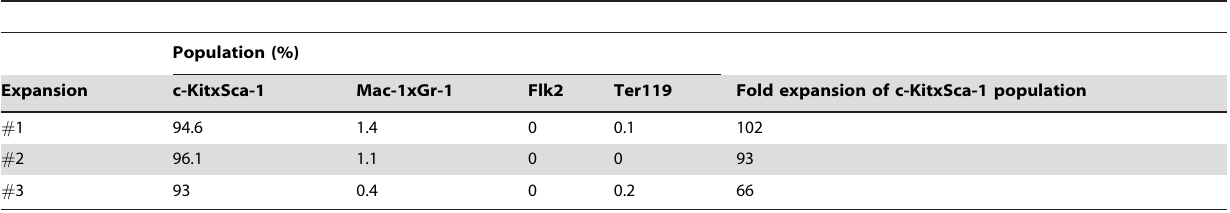
Table 2. ex vivo expansion of the murine c-Kit + x Sca-1 + x lin 2 cells with Tat-MYC and Tat-Bcl-2 in three independent